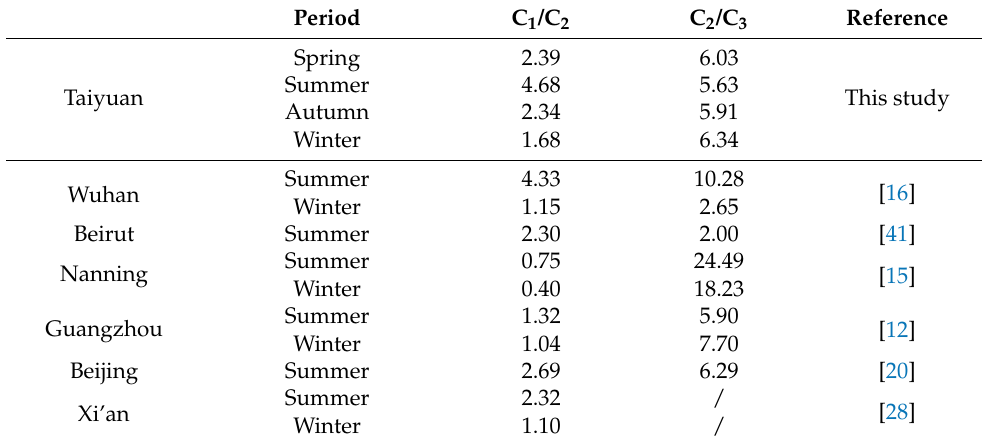
Table 2. C 1 /C 2 and C 2 /C 3 ratios during the sampling periods in Taiyuan. Period C 1 /C 2 C 2 /C 3